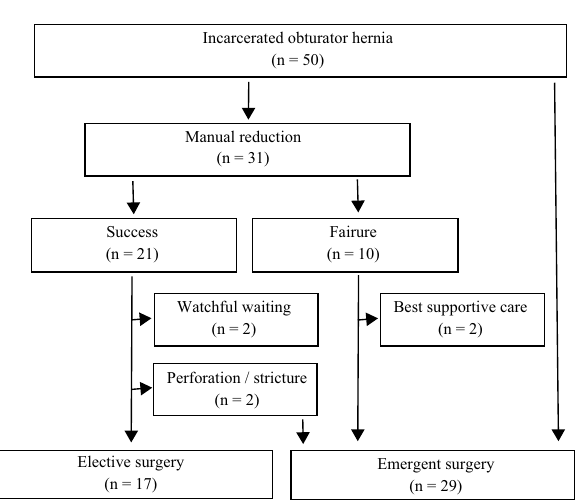
Figure 5. Patient flowchart. Manual reduction was attempted in 31 patients. Reduction was successful in 21 patients, two selected watchful waiting, and 19 selected elective surgeries, but two patients underwent emergent surgery in the waiting period. In 10 patients, manual reduction failed, 8 received emergent surgery, and two received the best supportive care. The remaining 19 patients underwent immediate emergent